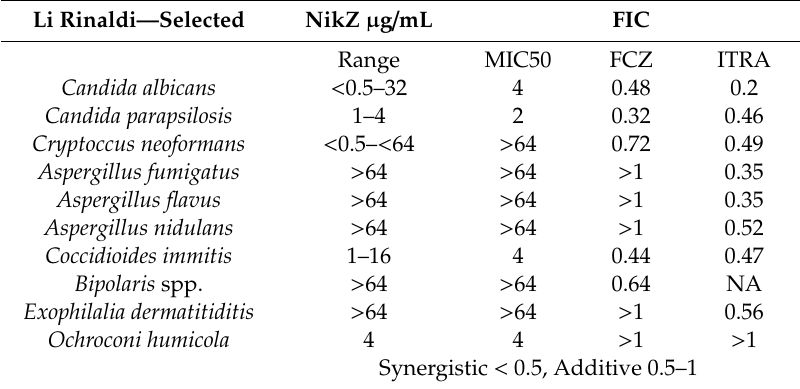
Table 1. NIKZ MIC, FIC against various fungi